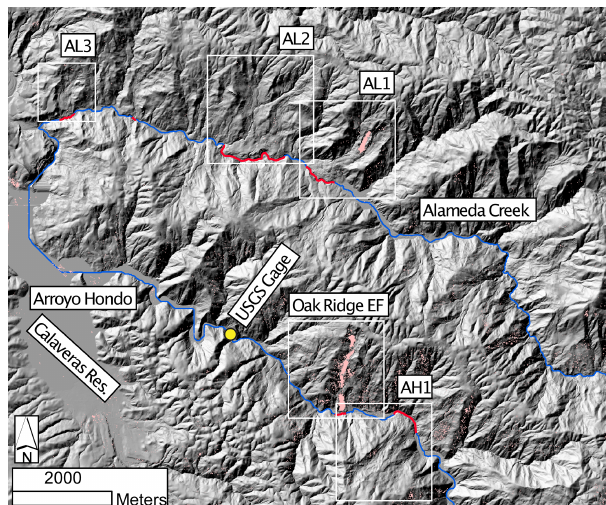
Figure 2. Shaded relief map of the study reaches of the Alameda Creek and Arroyo Hondo watersheds. White boxes highlight large mapped earthflows in the study area, which are shown in more de- tail in Fig. 3. Rivers channels are indicated with blue lines, except where they intersect active earthflows (red lines). Areas of light red shading show regions where the InSAR analysis indicated line-of- site velocities in excess of 3cmyr − 1